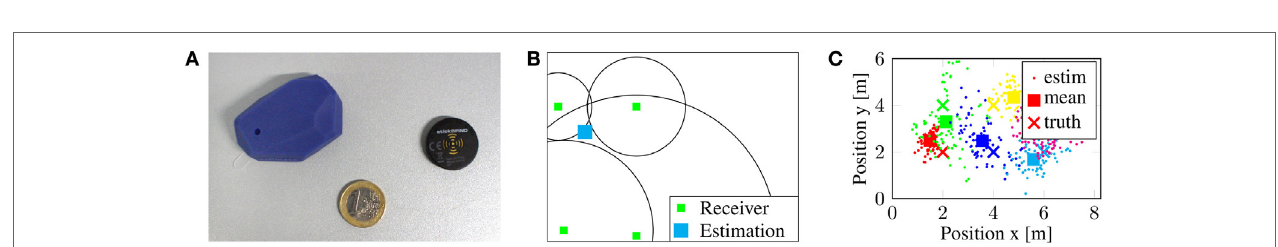
FIgURe 9 | Bluetooth low energy tag localization (Schwarz et al., 2015a) . (A) Used Bluetooth tags (Estimote and StickNFind). (B) Signal strength-based tag localization by lateration. (c) Localization experiment with multiple